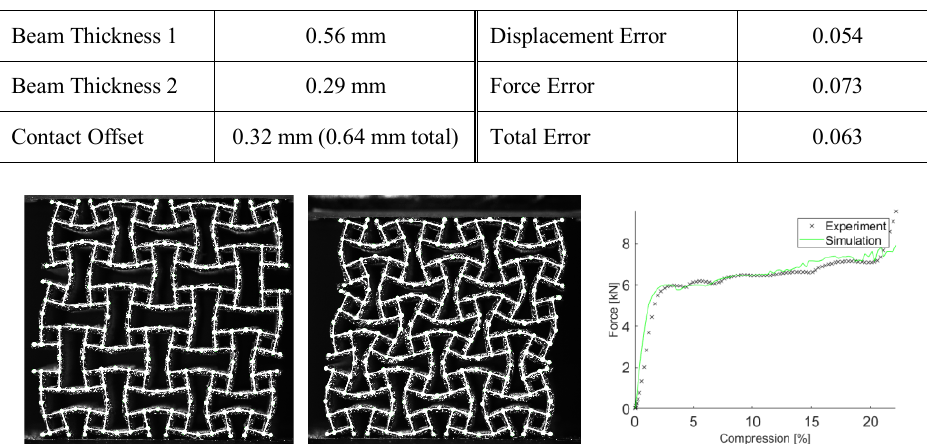
Table 1. Parameter and Error Results.